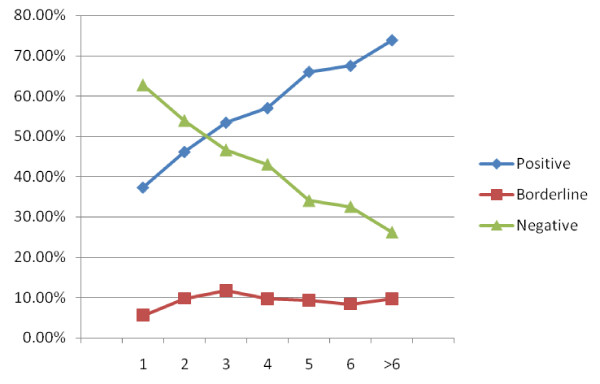
T. gondii seroprevalence in sheep according to age of animal. The percentage of sheep being T. gondii seropositive increased from 37.3%, in animals that are one year old, to 73.8% in animals that are more than 6 years old, while the number of borderline samples stayed fairly unchanged for the different age groups. Borderline cases were excluded from the calculation of the age-related T. gondii seroprevalence.